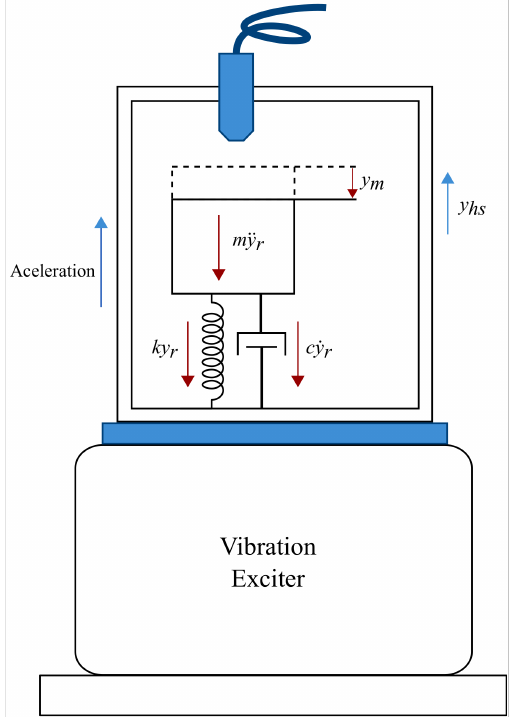
Figure 7. Acceleration of the metallic package and counter-reacting forces of the MEMS